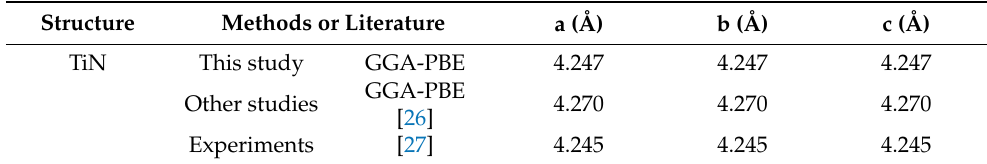
Figure 2. Crystal cell structures of ( a ) Ti 4 N 4 ; ( b ) Ti 3 CuN 4 ; and ( c ) Ti 4 N 3 Cu. Table 1. Unit cell parameters of TiN structure. Table 1. Unit cell parameters of TiN structure.